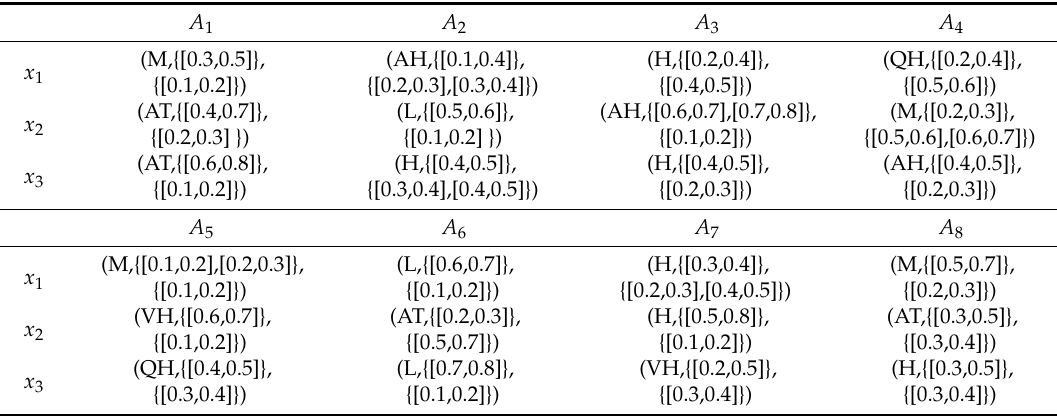
Table 3. The IVDHFUBL decision matrix R 2 provided by decision-maker E 2 .